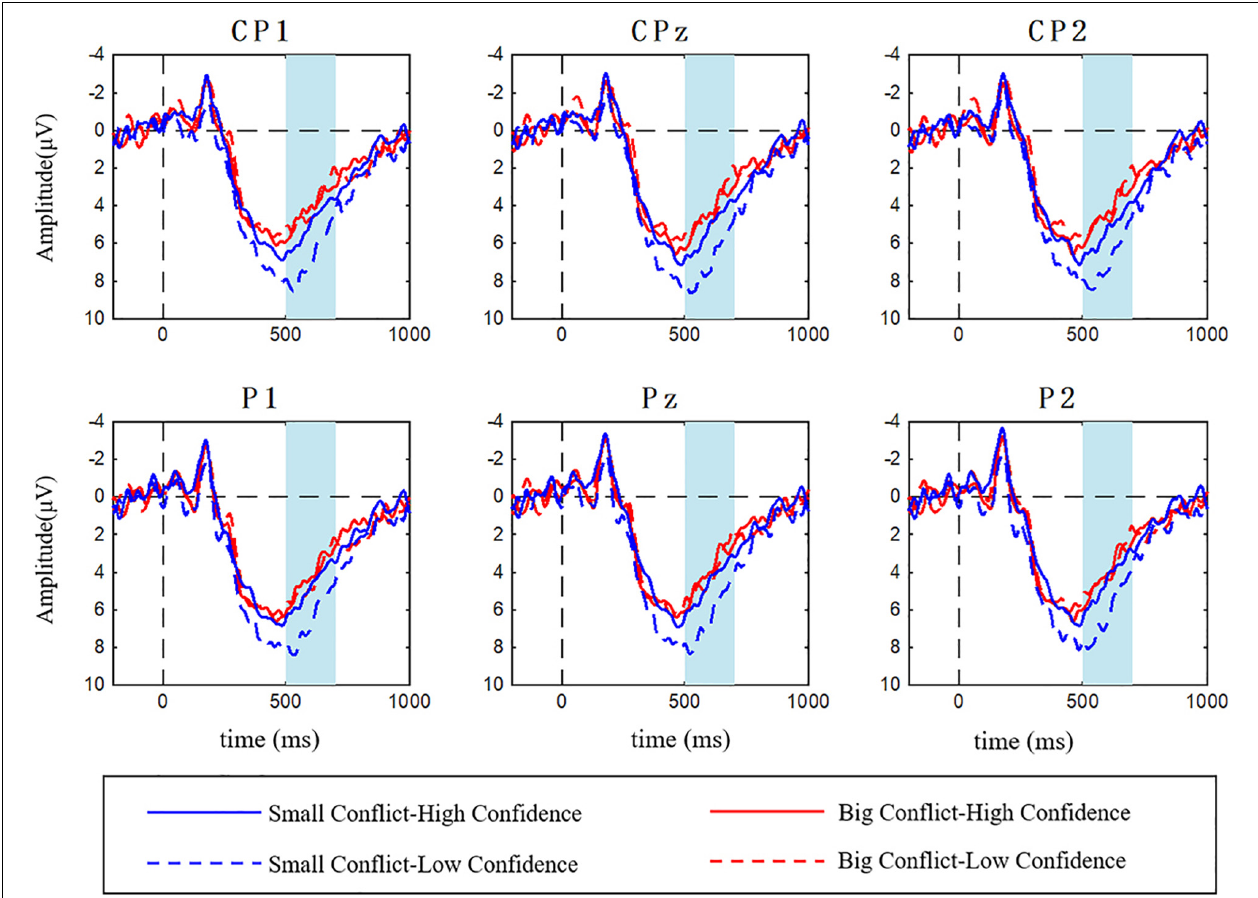
FIGURE 5 | Grand averaged ERPs elicited by confidence (low vs. high) × conflict magnitude (small vs. big) with LPP (the shaded area from 500 to 700 ms) at CP1, CPz, CP2, P1, Pz, and